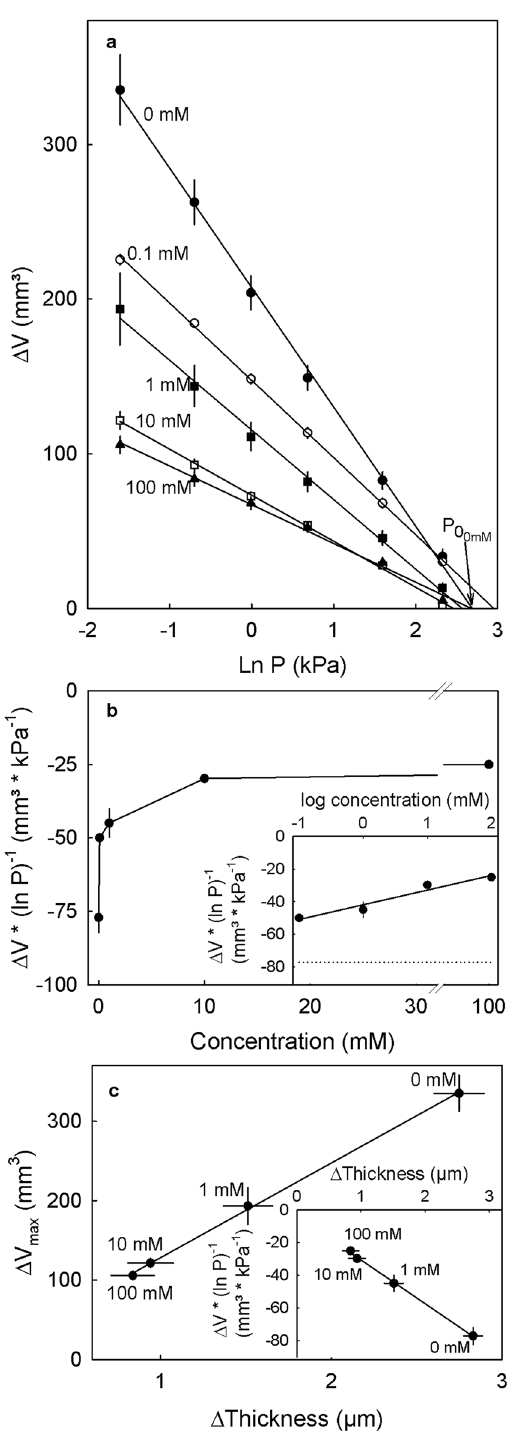
Figure 6. ( a ) Swelling of cell wall material extracted as the alcohol insoluble residue from ‘Burlat’ sweet cherry fruit when incubated in different concentration of CaCl 2 . All solutions were buffered with 10 mM MES and pH adjusted with KOH to 5.8. Swelling was quantified in vitro as the change in volume (∆V) at different pressures (P) using a custom-built pressure chamber. The ∆V of the swollen cell walls after loading the cell wall with different pressures was quantified. ( a ) Relationship between the swelling of cell walls (∆V) at equilibrium and the natural logarithm of the applied pressure. The swelling pressure P 0 corresponds to the pressure at which no swelling occurs. The value P 0 was estimated as the x-axis intercept of a regression fitted through a plot of ∆V vs. ln P. Each curve represents the mean of three repetitions. ( b ) Slope of the regression of ∆V vs. ln P depending on the CaCl 2 concentration of the incubation solution. Inset: Slope ∆V vs. ln P depending on the logarithm of the applied concentration of CaCl 2 . The dotted horizontal line represents the control of 0 mM CaCl 2 . ( c ) Relationship between maximum swelling of the extracted cell walls incubated with different CaCl 2 concentrations and the cell wall swelling examined on anticlinal cell walls of excised epidermal segments of ‘Burlat’ sweet cherry fruit incubated in the same incubation solutions. The ES were treated with a freeze/thaw cycle to release turgor followed by an incubation of 48 h. The cell wall swelling was calculated by the difference in the cell wall thickness after release of turgor minus that before release of turgor. Inset: Relationship of the slope ∆V vs. ln P and the microscopically determined cell wall